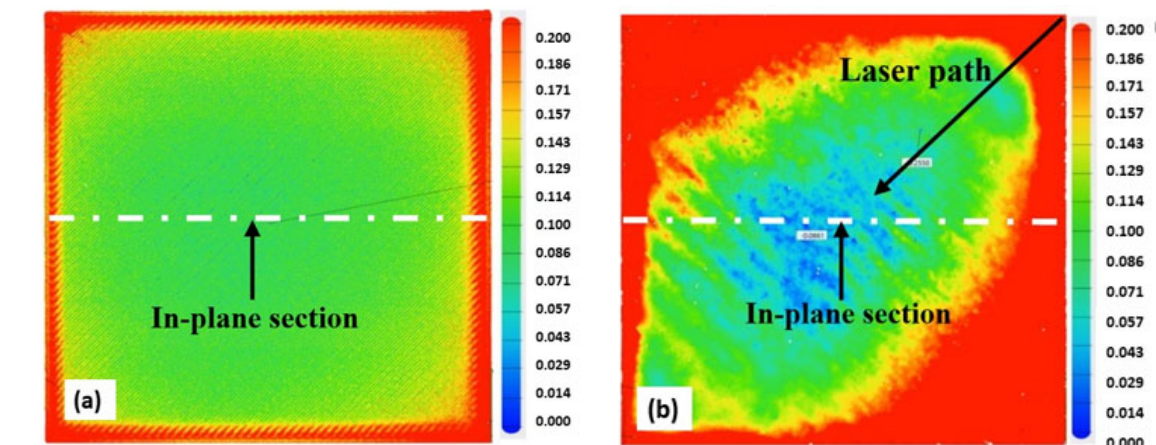
Figure 8. Variation in surface roughness reduction (measured at 90°) with energy density.